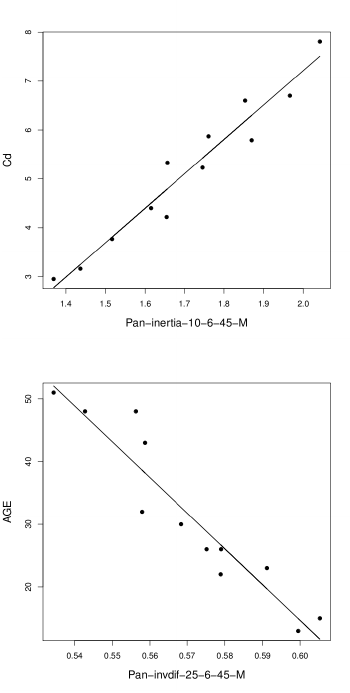
Figure 2: Relationship between forest structure variables and selected image features Figure 2 shows some of the best achieved relationships between forest variables and image features. Linear presumptions are con- firmed and no alarming behaviors are noticeable on residual plots.